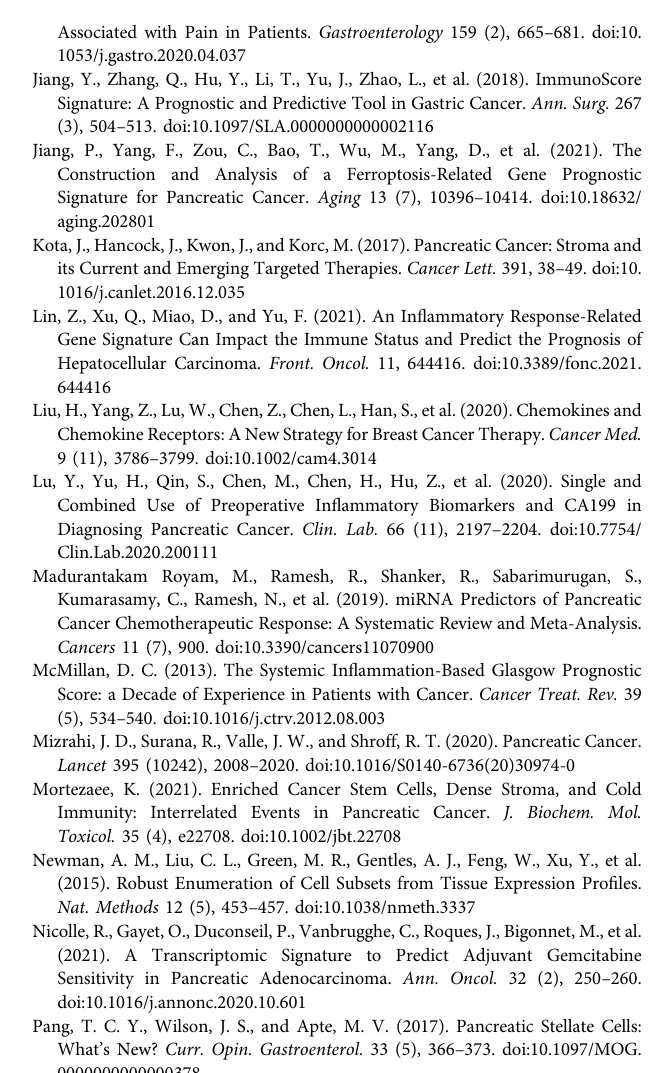
Supplementary Figure 1 | Association between the signature and clinical parameters in the E-MTAB cohort. (A,B) KM curves for T-staging subgroups in high- and low-risk patients, respectively. (C,D) KM curves for lymph node metastasis status subgroups in high- and low-risk patients, respectively. (E,F) KM curves for resection margin status subgroups in high- and low-risk patients,